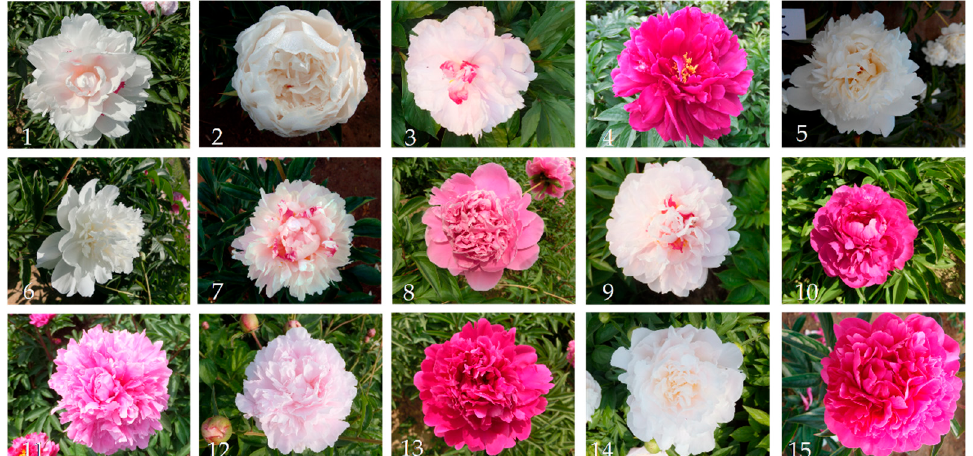
Figure 1. External morphology of Paeonia lactiflora flowers: 1 , Xueyuanhonghua; 2 , Yangfeichuyu; 3 ,